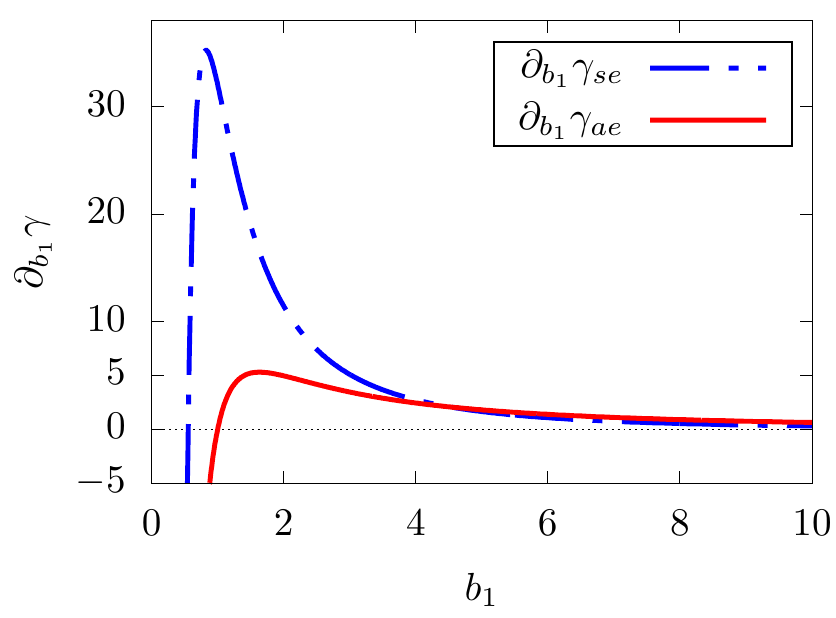
Figure 6 . The quantity ∂ b γ se is plotted with respect to varying b 1 for accelerated atoms in thermal 1 background in (1+1) dimensions, depicted by dash-dotted blue line. The quantity ∂ b with respect to varying b 1 for accelerated atoms in thermal background in (1 + 1) dimensions, depicted by red